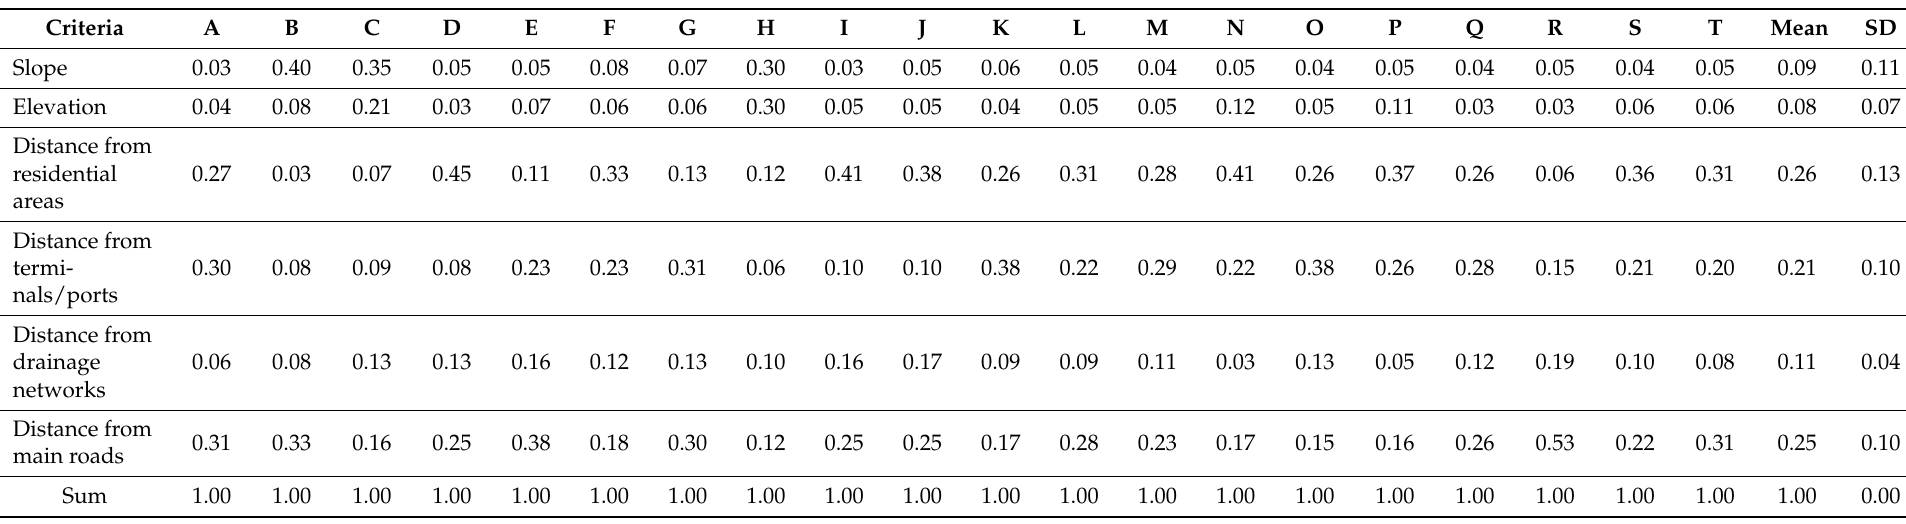
Table 4. Weights of the criteria for commercial areas suitability mapping using AHP.